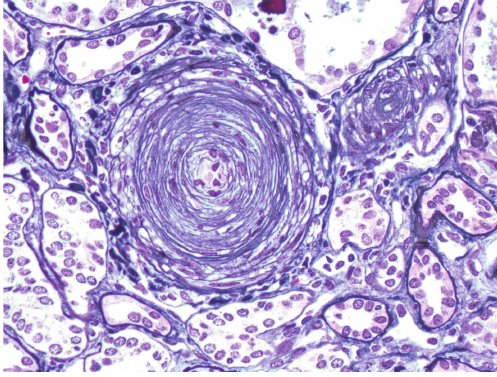
Figure 2: Prominent arterial onion skin lesion in a patient with scleroderma renal crisis. Such lesions often cause severe vascular narrowing leaving only a pinpoint open lumen (Methenamine silver stain; original magnification x400).